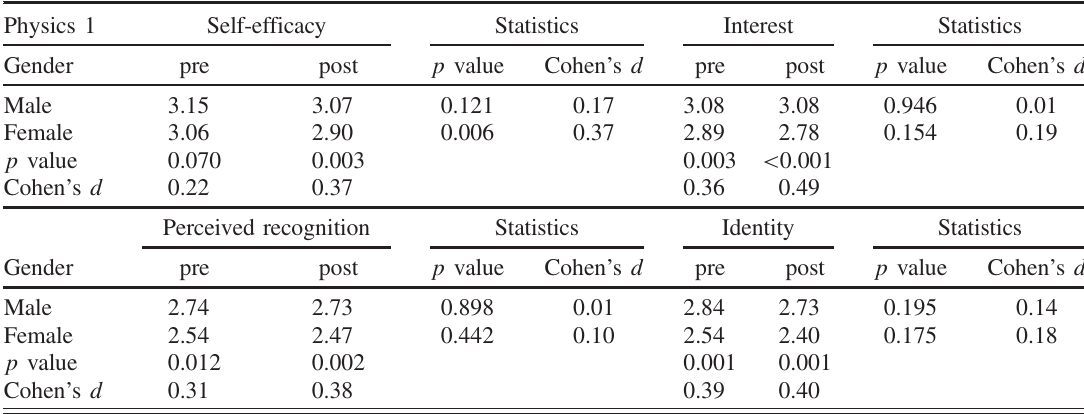
TABLE IX. Descriptive statistics of female and male students ’ motivational beliefs in physics 1 in the second year studied. The sample size is 291 (179 male students and 112 female students). Cohen suggested that a typical value d ∼ 0 . 2 be considered a small effect size, d ∼ 0 . 5 represents a medium effect size and d ∼ 0 . 8 a large effect